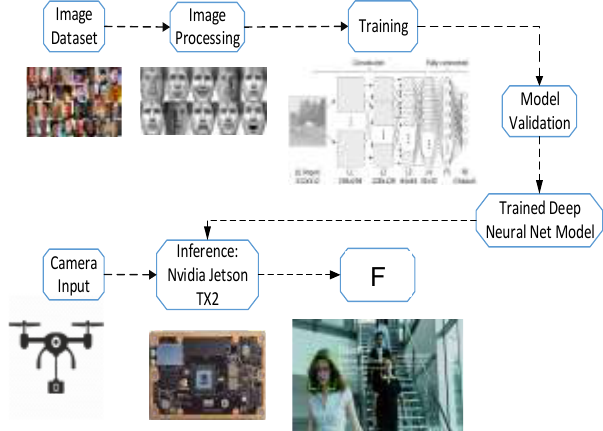
Fig. 3. Face recognition system flowchart